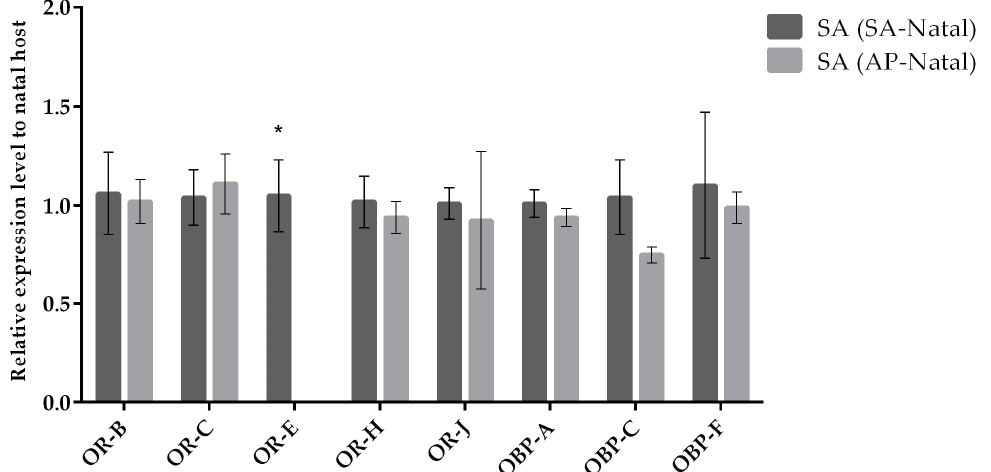
Figure 3. Mean (+/ − SE) mRNA expression levels of ORs and OBPs from the heads of A. ervi maintained on the natal host S. avenae (SA-Natal) or switched from A. pisum to the non-natal host S. avenae (AP-Natal) measured by RT-qPCR. RT-qPCRs were performed using specific primers for each gene. Normalizer gene: RPL19. The asterisk * above the bars indicates significant differences according to two-way ANOVA ( p value < 0.05).